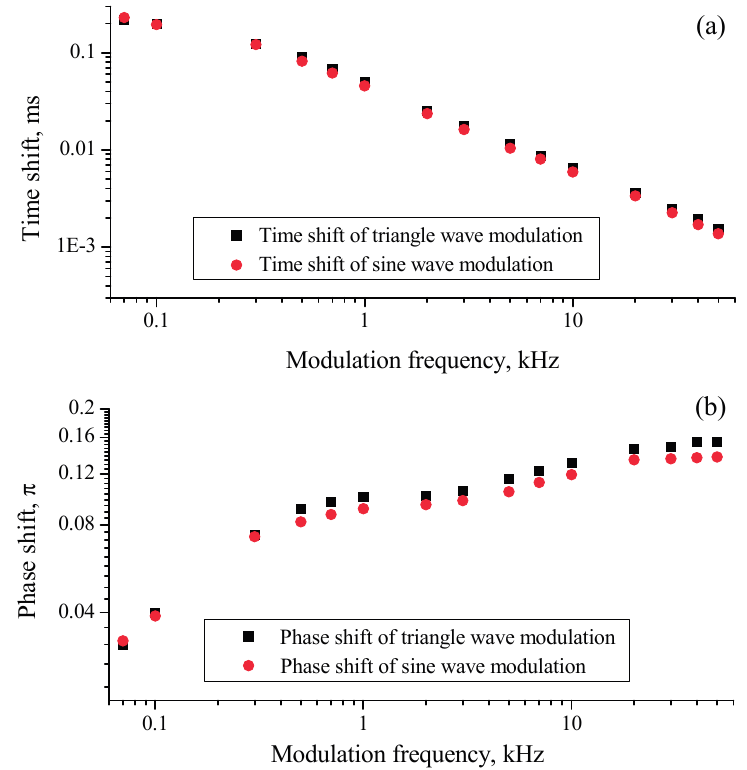
Figure 4. ( a ) Time shift of triangle wave modulation (black square) and sine wave modulation (red dot) at modulation frequencies from 50 Hz to 50 kHz; ( b ) Phase shift of triangle wave modulation (black square) and sine wave modulation (red dot) at modulation frequencies from 50 Hz to 50 kHz. All the axes are logarithmically